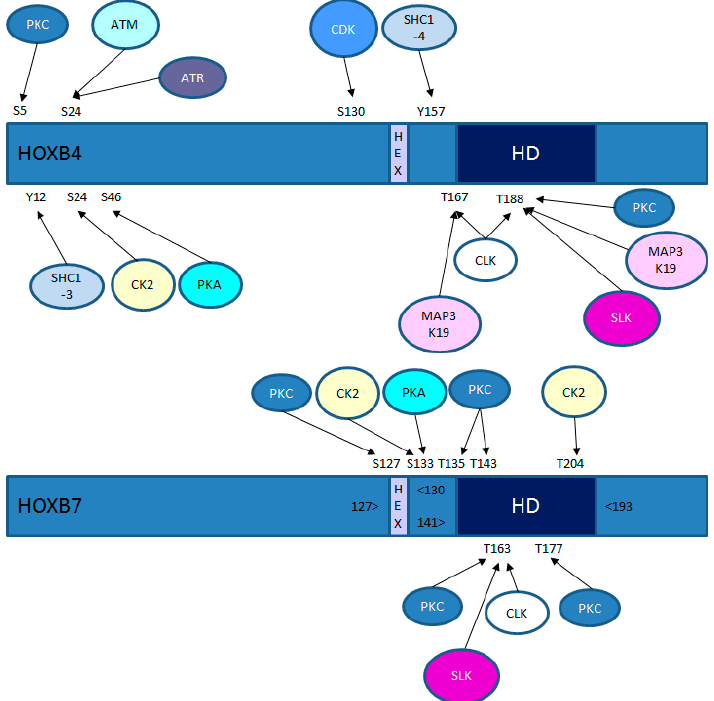
Figure 1. Consensus kinase sites in HOXB4 and HOXB7. The relative positions of the conserved hexapeptide domain (“HEX”) that mediates Pre-B-cell Leukaemia Homeobox (PBX) binding and the homeodomain (“HD”) that mediates DNA binding are shown. ATM, kinase mutated in ataxia telangiectasia; ATR, ataxia telangiectasia and Rad3-related protein; CK2, casein kinase 2; CDK, cyclin-dependent kinase; CLK, CDC2-like kinase; MAP3K19, mitogen-activated protein kinase kinase kinase 19 (also known as RCK and YSK); PKA, protein kinase A; PKC, protein kinase C; SLK, STE-20 like serine/threonine protein